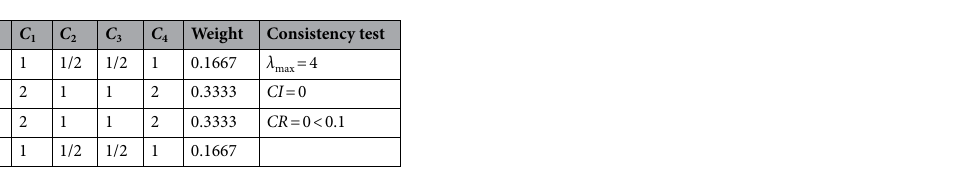
Table 6. Coating protection performance judgment matrix.